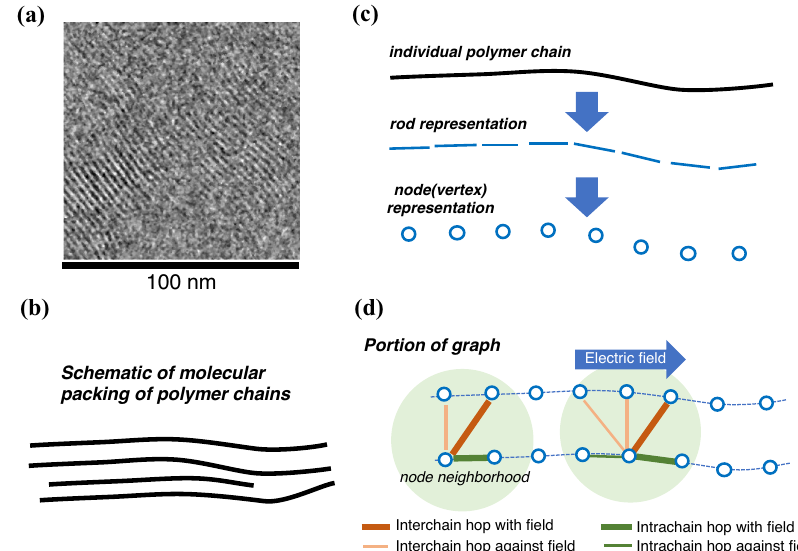
Fig. 1 Schematic illustration of the graph-based charge transport model. The model takes in an HRTEM image, identi fi es local order of polymer chains, represents with nodes to form a graph network which is then used to represent charge transport along a speci fi ed electric fi eld